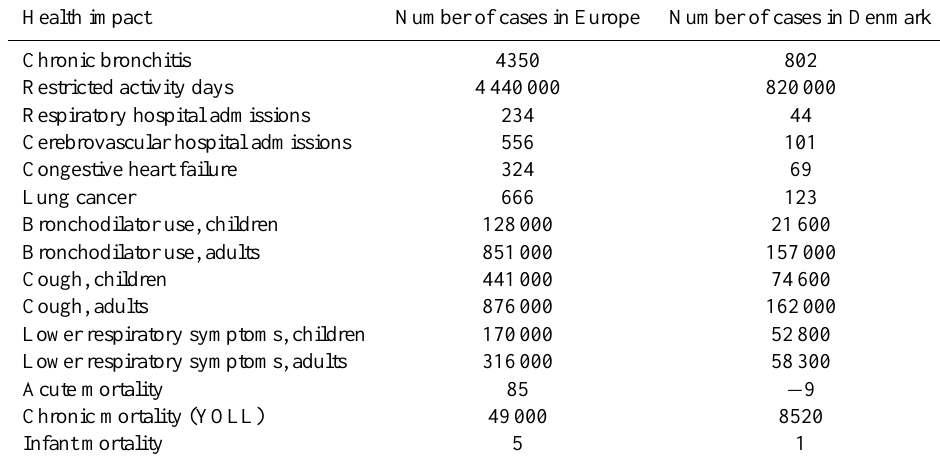
Table 4. The total external costs in million euros per chemical com- pound for the whole of Europe from anthropogenic Danish emission sectors for the year 2000. Total S is the sum of the external cost of SO 2 and SO 2 − . Total N is the sum of the external costs of O 3 and 4 NO − . The external costs from NH 3 emissions are included in the 3 impacts related to S and N through chemical reactions in the atmo-